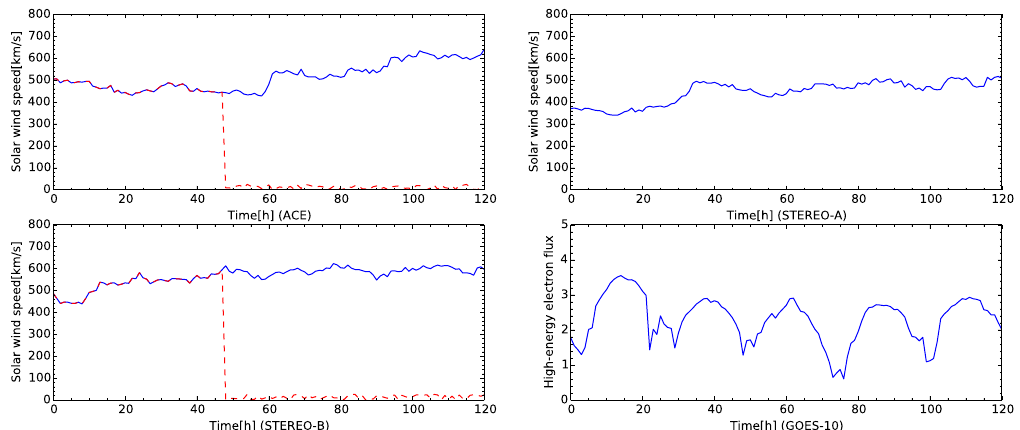
Figure 9. Time development of the test case for five days from 1 May 2008 at 00:00:00 UTC. The satellite names are labeled in horizontal axes. The plots in the first row and left one in the second row show the time development of solar wind speed. The right plot in the second row shows the time development of the high-energy electron flux. The solar wind plots for ACE and STEREO-B also show the abnormal data for the test (dashed